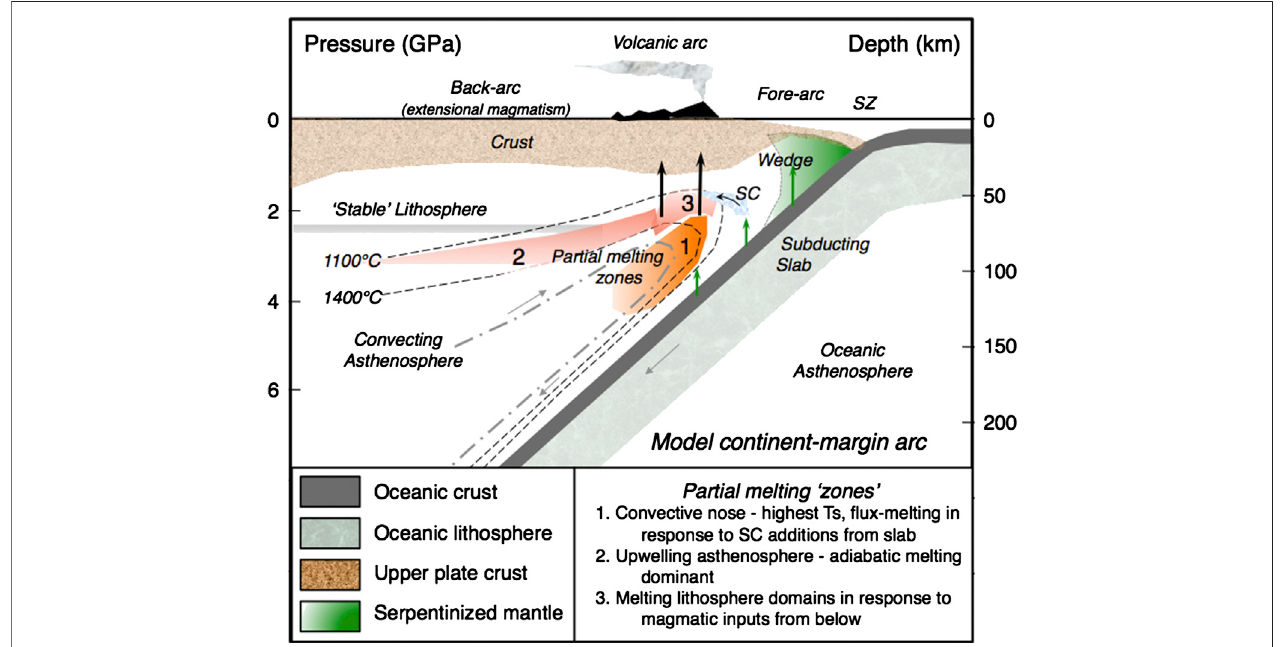
FIGURE 14 | Schematic cross-section of a generalized continental margin subduction zone showing important petrologic and geochemical domains. Boundary betweennon-convectinglithosphericmantleportionoftheupperplateandtheunderlyingconvectingasthenosphericmantleishighlyschematic.Lightarrowsrisingfrom the subducting slab signify transfer of fl uids and/or melts from slab to lower mantle wedge; in warm Cascadia the shallow wedge is considered to be strongly serpentinized due to shallow slab dehydration. A blue-shaded arrow symbolizes how subduction components (SC) may be distributed into the convecting mantle wedge(cf.Cerpaetal.,2018).Thisandthedistributionofpartialmeltswithinthewedgearehighlydependentuponmanyfactors(cf. Figure2 ofthispaper).Itisgenerally believedthatmanyarcmagmasare1)generatedwithinthemantlewedgepartlyinresponsetothecatalyticeffectofaddingslab-derived waterand/ormelts,2)enriched in other components that produce distinctive calcalkalic charateristics, and 3) modi fi ed by reactions with progressively warmer mantle as they rise, thus accounting for their elevated temperatures (cf. Grove et al., 2012). In the fi gure, location “ 1 ” signi fi es a likely position from which such magmas may ascend beneath arcs (bold vertical arrows). A second style of magmatism is related to decompression of convective limbs in the mantle wedge; e.g., region “ 2 ” in the fi gure. Such melts are formed and releasedover abroadbackarc regionand intheuppermostpart ofthe ascending asthenosphericlimb. Ifdirect inputs ofSCfromthe currently subducting slabaresmall to negligible, these melts are likely to resemble intraplate magmas (LKT and possibly OIB-like variants), depending upon the history and compositional structure of the convecting asthenosphere. Itisprobable that thetransfer ofheat (and possibly fl uids)by magmasascending from domains “ 1 ” and “ 2 ” will promote warming and partial meltingofpartsofthelithosphericmantle;e.g.,region “ 3. ” Suchmeltscouldformbyremeltingearlieremplacedmagmaticbodiesaswellasmorerefractorycomponents of the old lithospheric mantle. Considering the unusually warm nature of the Cascadia SZ, involvement of slab-derived fl uids is likely relatively small during Quaternary time, and appears unlikely to dominate the style of magma productivity in this arc. The smaller leverage of fl uid-related processes may contribute to the apparent eminence of intraplate-like magmatism, to increased production of slab melting locally, and to generally high magmatic temperatures in primitive basaltic magmas — overall a higher involvement of adiabatic vs. aqueous fl ux melting. Conversely, in cooler SZs, greater in fl uence of slab-derived fl uids is likely to shift the magmatic spectrum toward the calcalkalic fl